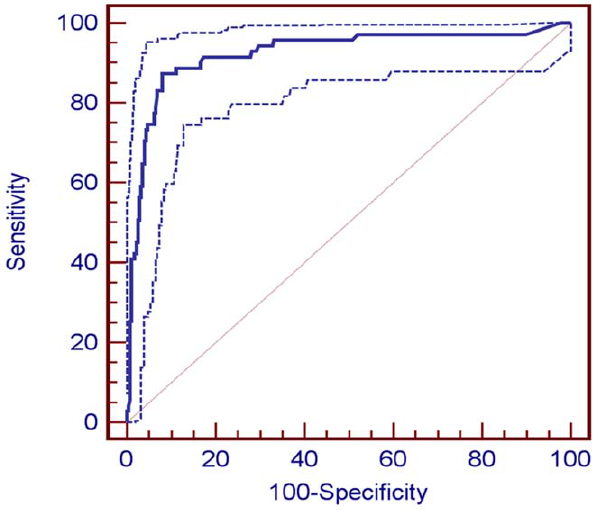
Figure 3. Receiver operating characteristic (ROC) curve for predicting cancer-related stroke from plasma D-dimer levels. The area under the ROC curve (AUC) 6 standard error was 0.945 6 0.182 ( P , 0.001). The dotted lines indicate 95% confidence interval (0.916 to 0.967).